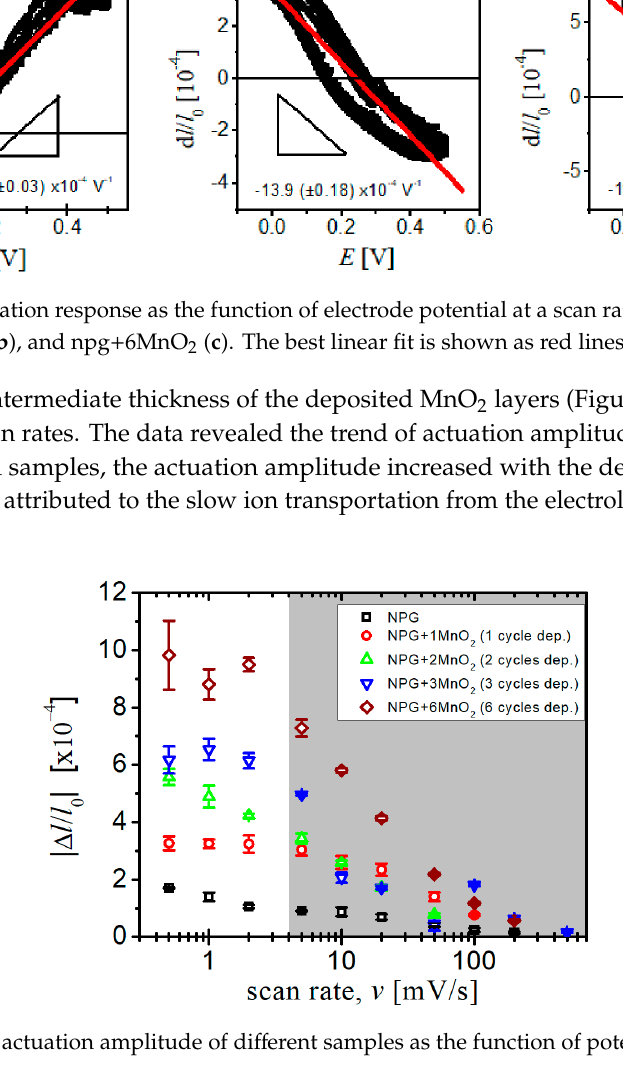
Figure 4. The actuation amplitude of di ff erent samples as the function of potential scan rate.